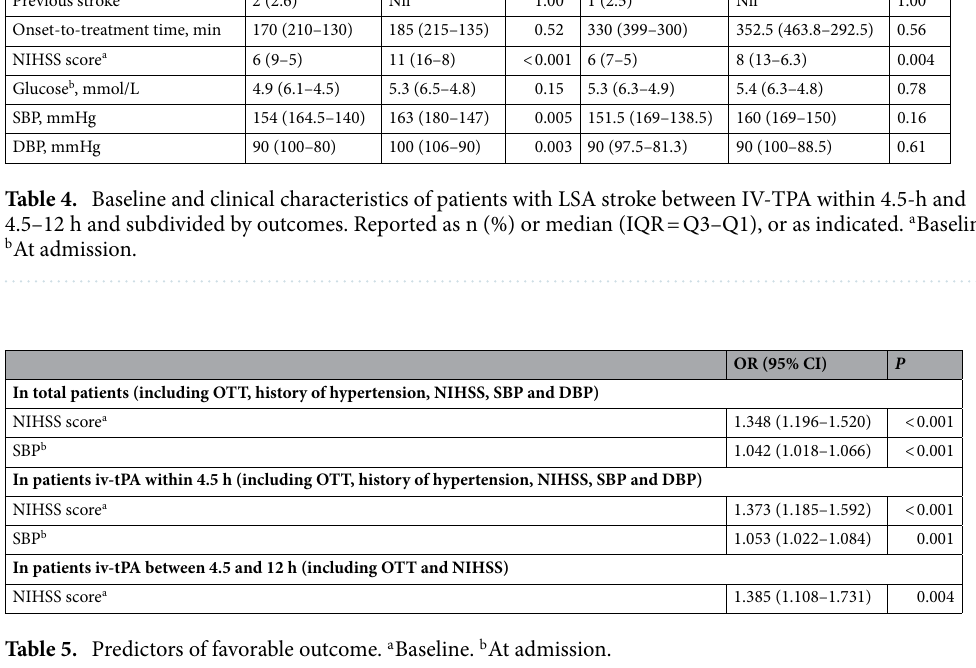
Table 5. Predictors of favorable outcome. a Baseline. b At admission.